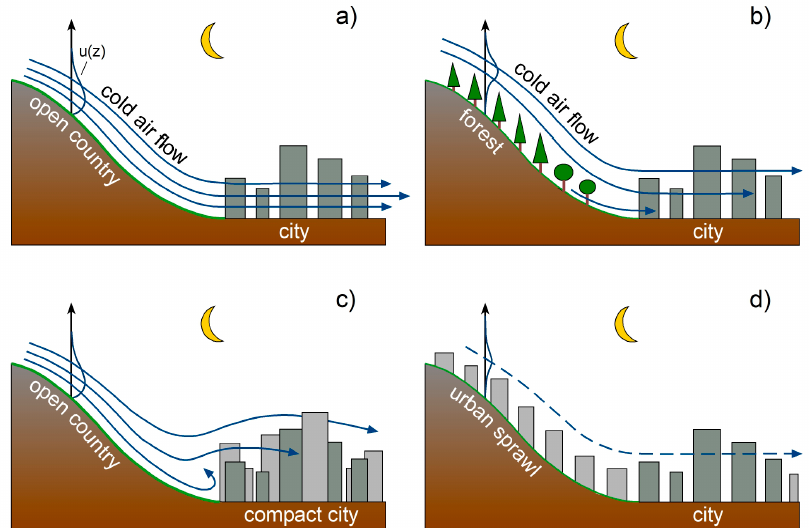
Figure 5. Schematic representation of nocturnal drainage wind ventilation in cities with different surrounding landscapes and urban planning scenarios. ( a ) Well ventilated city surrounded by open country with strong formation of local cold air; ( b ) Nocturnal ventilation of a city surrounded by forest with cold air formation at tree crown level; ( c ) A compact city with preservation of surrounding open country: the higher density among buildings causes blocking and lifting of drainage winds; ( d ) Urban sprawl scenario: strong reduction of rural cold air and drainage wind formation. Blue lines indicate streamlines and vertical profiles of nocturnal drainage winds. Green lines indicate low surface vegetation over the hillslope. Existing buildings and planned buildings are shown in dark and light grey,